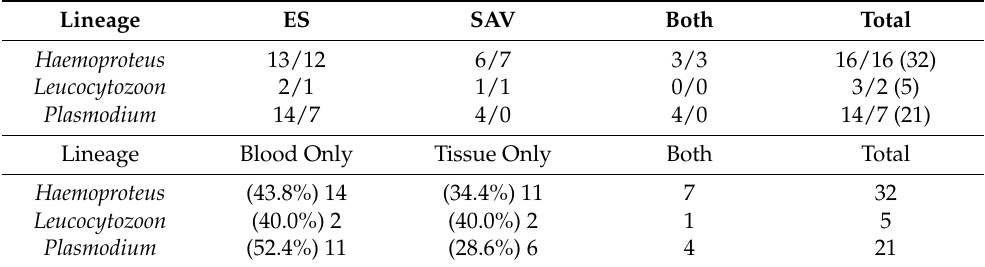
Table 2. Number of lineages recovered by location (ES and SAV) and by sample type (# of previously known lineages/# of novel lineages), as well as lineages recovered from blood only, tissue only, or